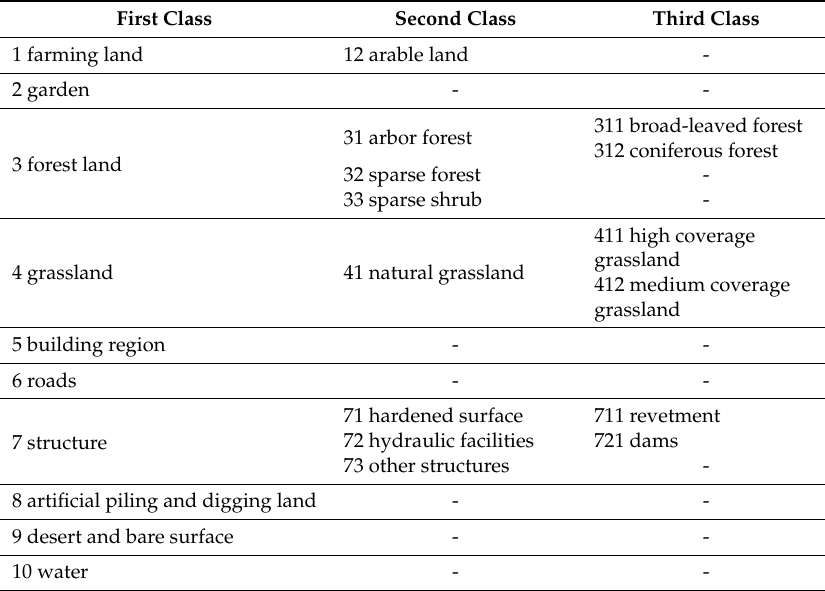
Table 4. LULC classification system used in this study.